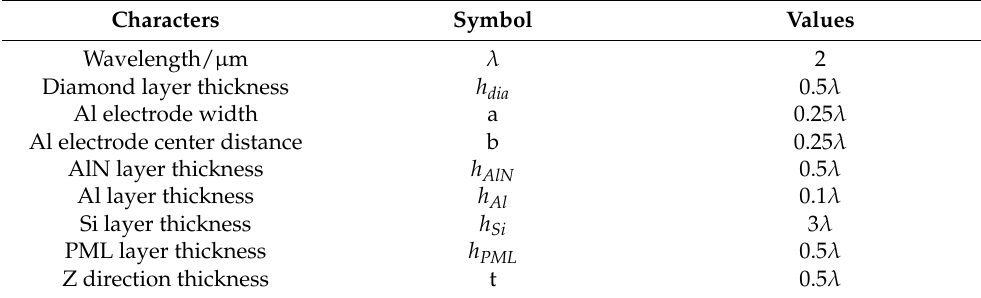
Figure 4. Geometric parameters and boundary conditions of element structures ( a ) planar graph of xy; ( b ) planar graph of yz. Table 1. Geometry characters of the FEM model.